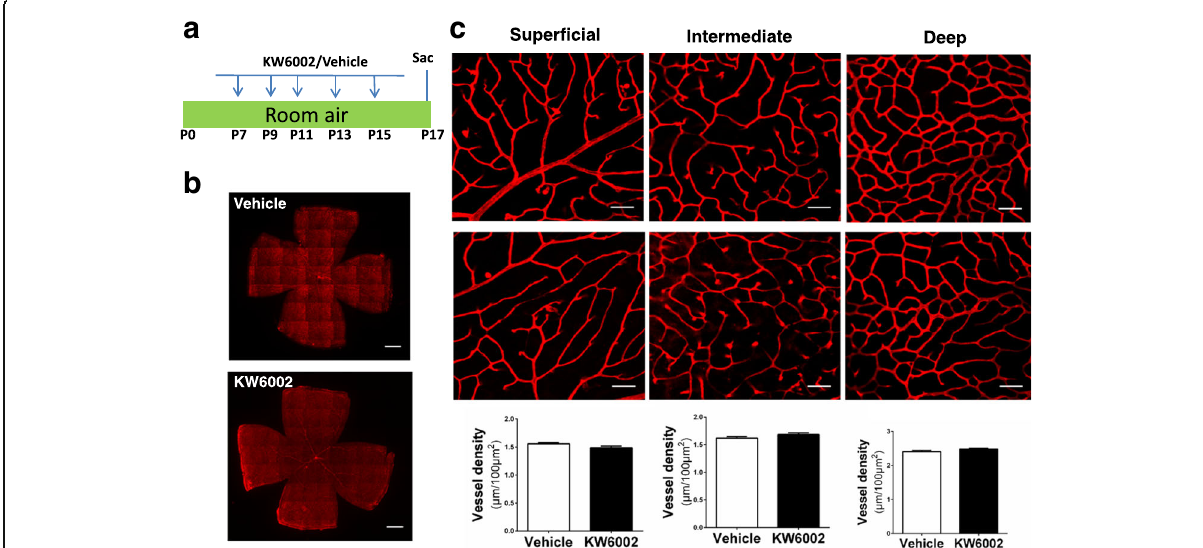
Fig. 1 KW6002 treatment did not affect normal postnatal development of retinal vasculature. a Schematic of the experimental design: KW6002 was administered by intraperitoneal injection at volume of 10 mg/kg from P7 to P15 every other day. Mice were euthanized at P17.(Sac:Sacrifice). b Mouse whole-mount retinas from KW6002- and vehicle-treated mice were harvested and immune-stained with isolectin B4. The retinal vasculature morphologies were indistinguishable between KW6002- or vehicle-treated pups at P17 in room-air. Scale bar: 500 μ m. c The retinal vasculatures of the superficial, intermediate and deep vascular layers were examined at P17 by isolectin B4 staining of whole-mount retinas. The distributions of three retinal vascular layers were displayed in distinct confocal planes. Vessel density was quantified as the ratio of the total vessel length to microscopic field. The vessel densities of the superficial, intermediate and deep plexuses were indistinguishable between KW6002- treated and vehicle-treated pups. Scale bar: 50 μ